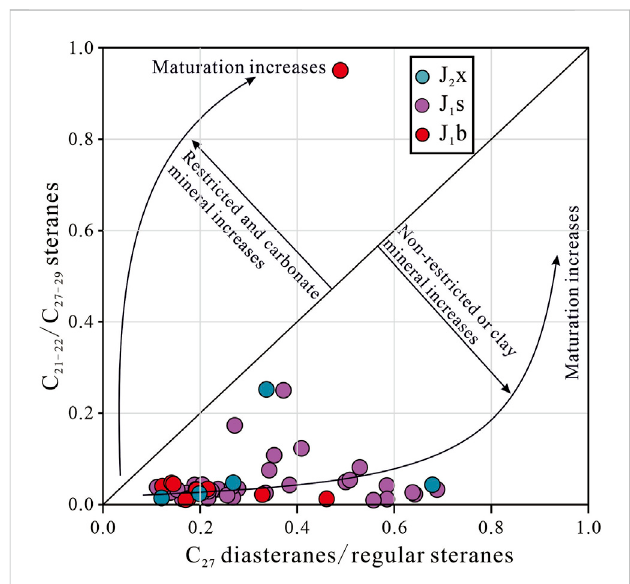
FIGURE 7 Plot of C 21 – 22 /C 27 – 29 steranes vs C 27 diasteranes/regular steranes, showingthedepositional